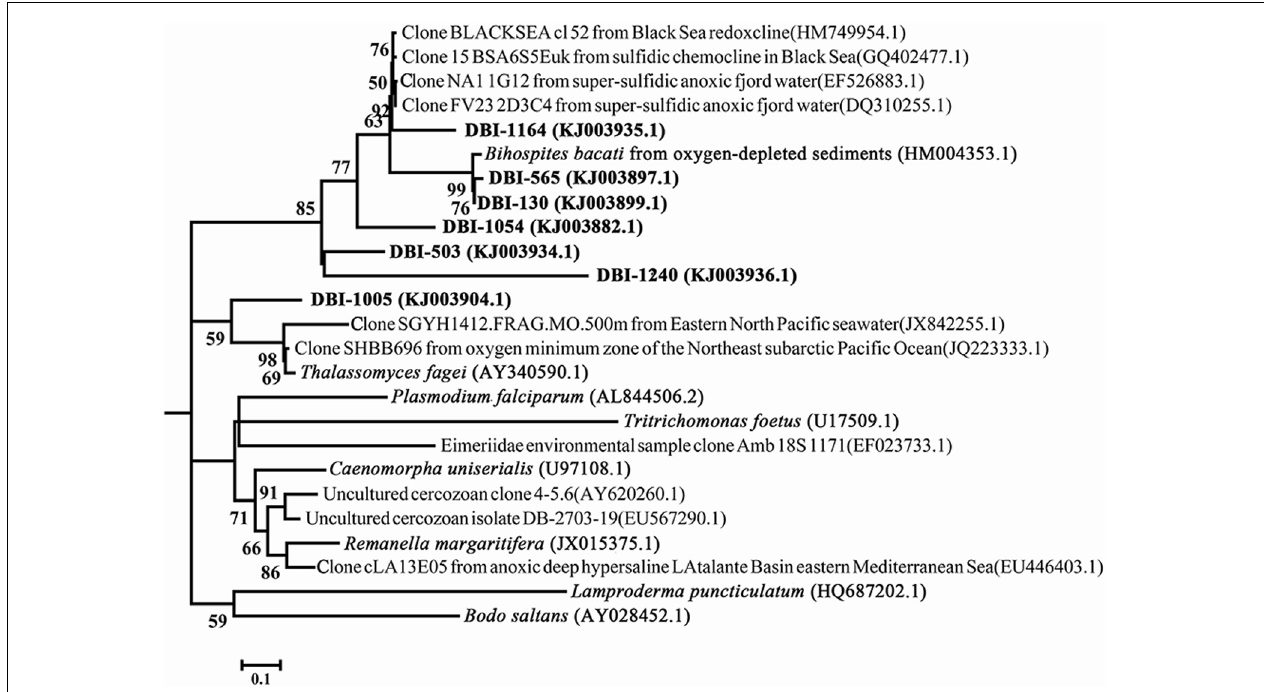
FIGURE 4 | Intra-structure of clade 3 with more reference sequences. The 7 OTUs selected at a dissimilarity of 20% constitute clade 3 in Figure 2 . The only reference sequence in the clade was from Bodo saltans . Bootstrap values > 50 in the maximum-likelihood phylogenetic tree are